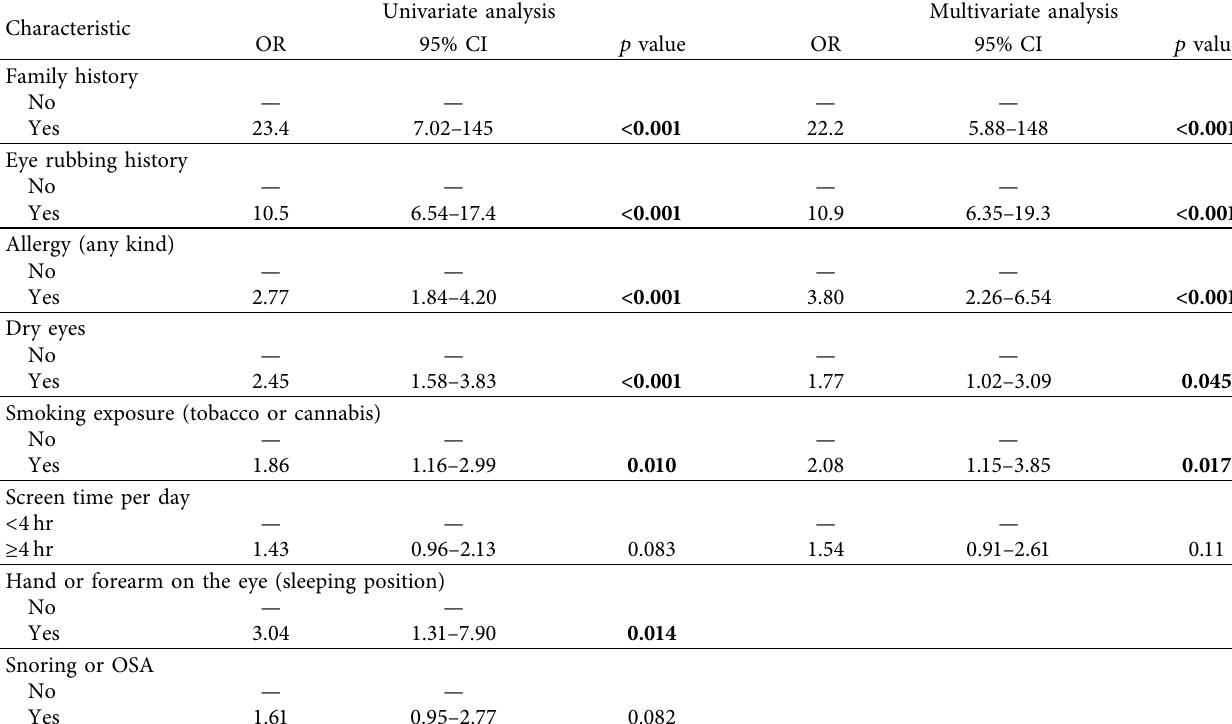
Table 3: Risk factors of keratoconus and multivariate logistic regression.